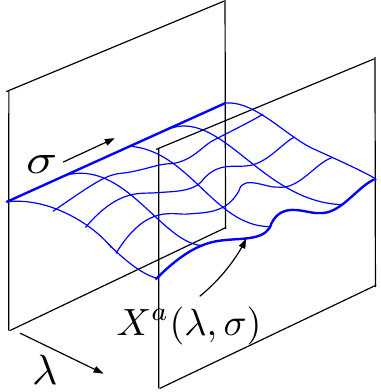
Figure 1: We can interpret the unitary U as making the Cauchy slice a dynamical surface parametrised by X a ( λ , σ )